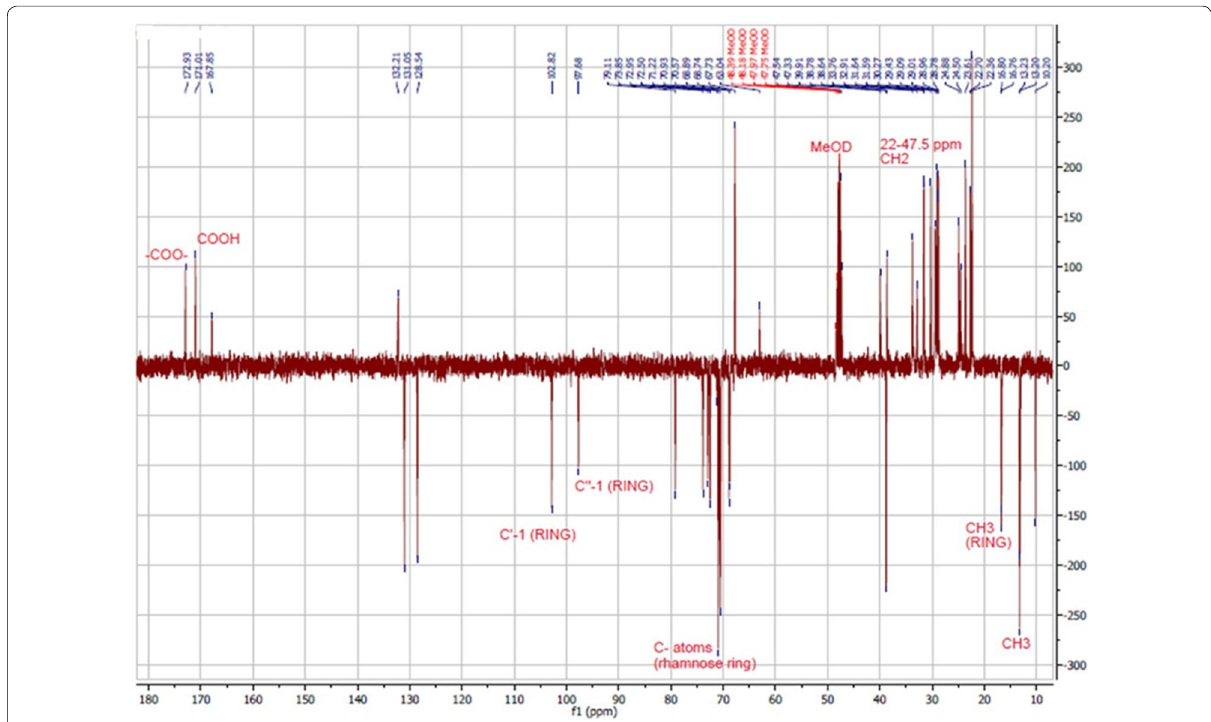
Fig. 2 13 C NMR spectrum (APT) of the RLs extracted from P. aeruginosa